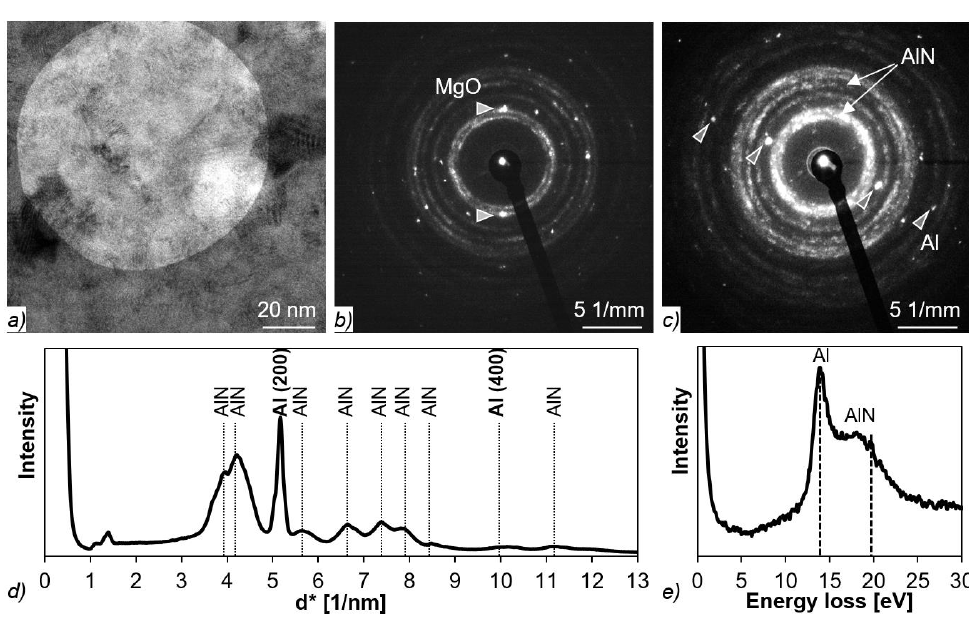
Figure 6. HRTEM images focussed on the interface (dotted line) between the AlN layer and the Al base material: ( a ) overview, ( b ) without, and ( c ) with diffusion-induced cavity after nitriding; higher resolution images of interfacial areas I., II.: ( d ) area I. with coherent bonding, and ( e ) area II. with incoherent bonding (dotted lines: exemplary lattice planes).